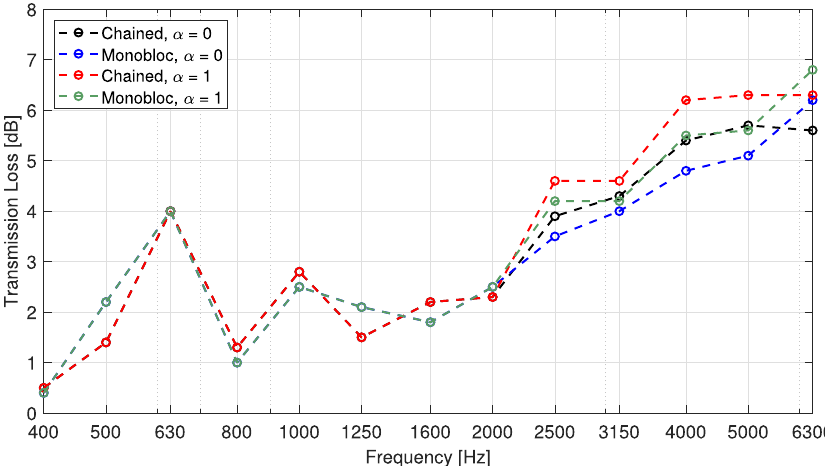
Figure 10. Transmission loss due to the association of two rigid expansion chambers.